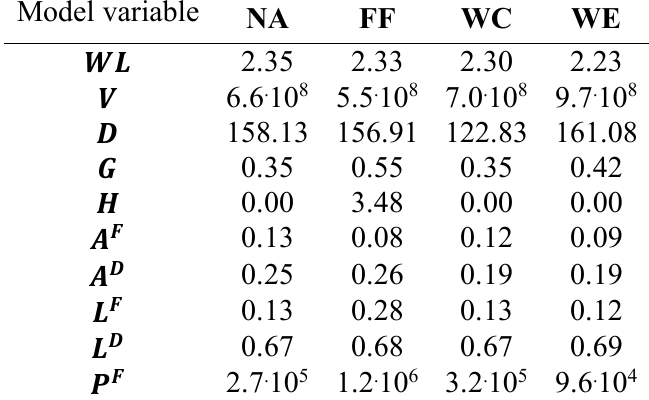
Table A6. Average values of different model variables obtained for the synthetic experiment additional scenario #5 with dam construction and four water management strategies (NA: No Actions; FF: Fighting Floods; WC: Water Conservation; WE: Water Exploitation)